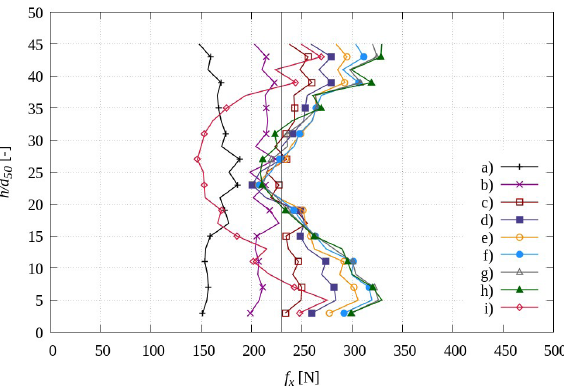
acting on spheres x at the specimen centre 50 = 0.50 mm, c) u = 0.75 mm, d) u = 1.00 x x x = 1.50 mm, g) u = 1.75 mm, h) u = 2.00 x x x = 0.60, σ = 200 kPa, d = 0.5 mm) 0 0 50